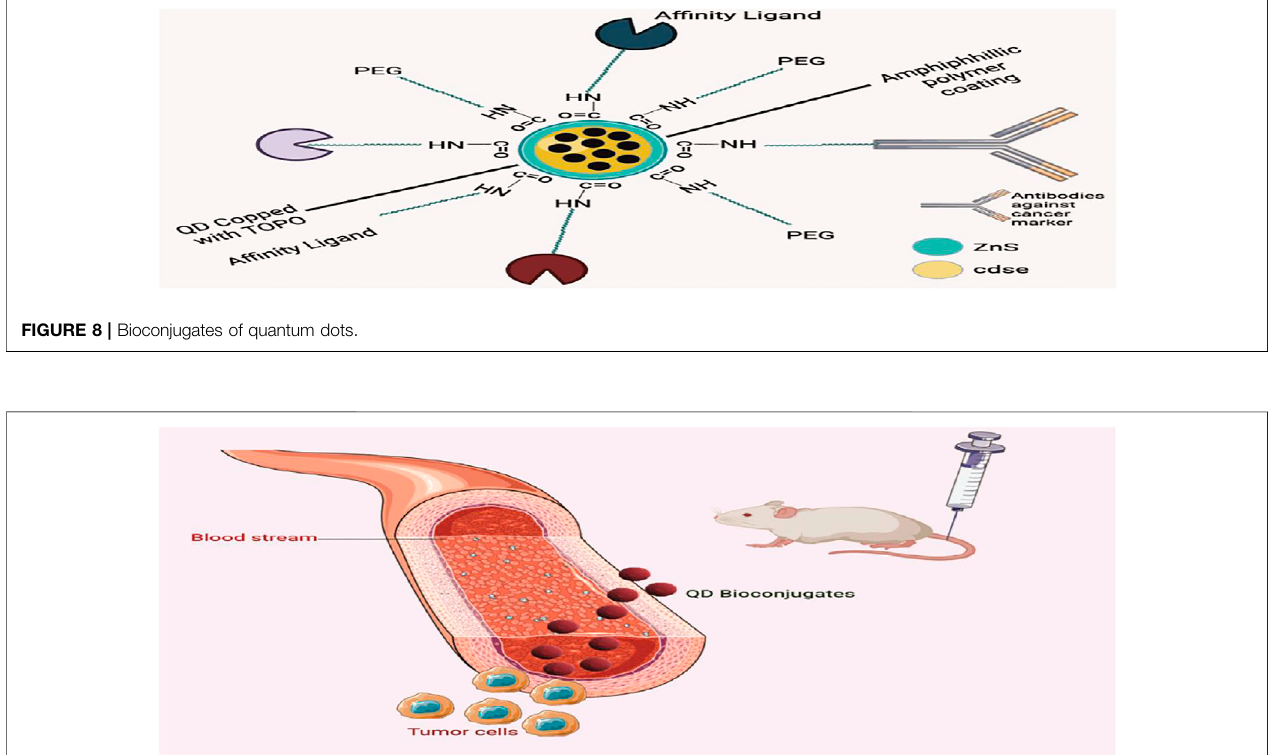
Frontiers in Materials |